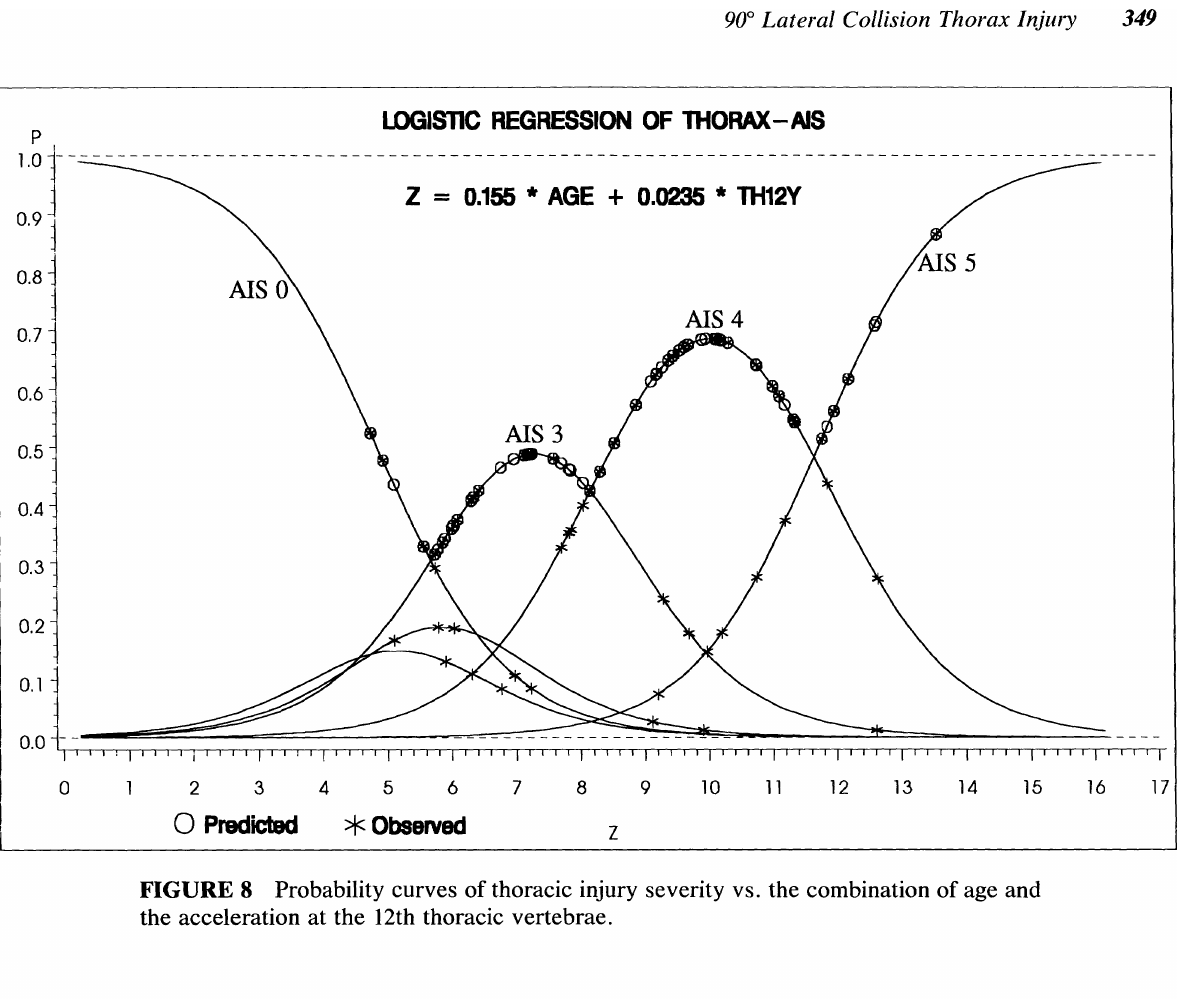
FIGURE 8 Probability curves of thoracic injury severity vs. the combination of age and the acceleration at the 12th thoracic